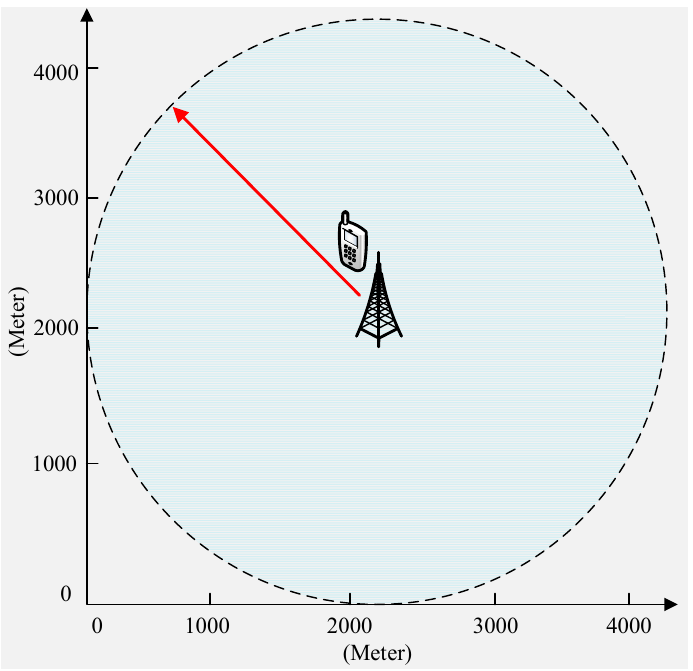
Figure 5. Network topology. Figure 5. Network Table 4. The network parameters used in the simulation.